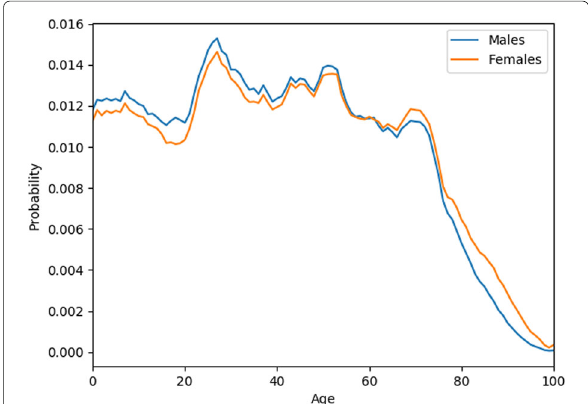
Fig. 4 Truncated age distribution of males and females in Sweden between 0 and 100 years